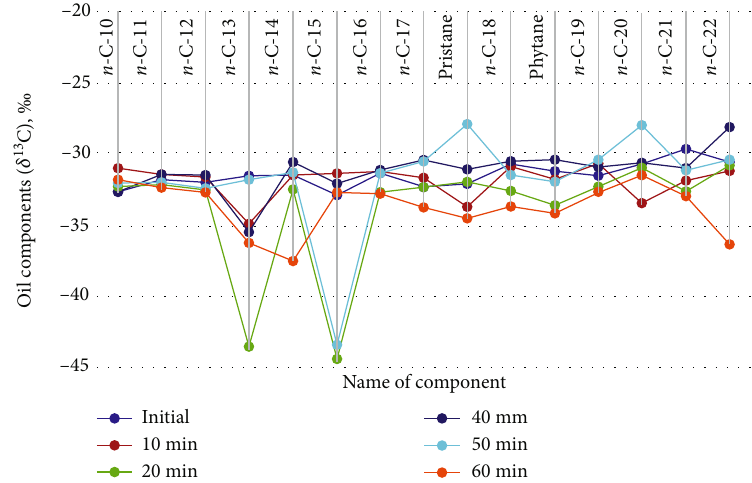
Figure 6: A change in the carbon isotopic composition ( δ 13C) of oil when exposed to a 50Hz electromagnetic fi eld [42].